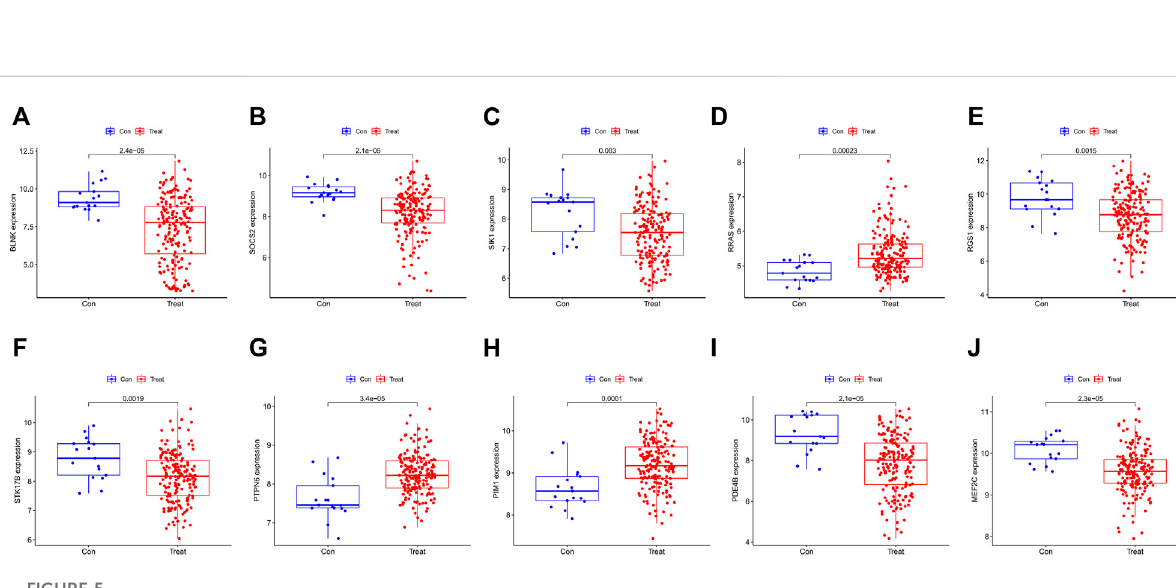
FIGURE 5 Box plots showing the differences in the expression of hub genes in MDS